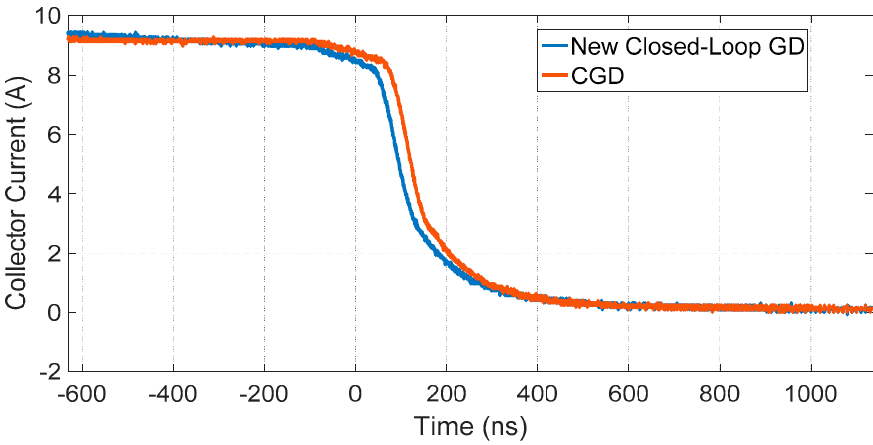
Figure 9. The resultant i C from the closed-loop GD and CGD at turn-off condition. Table 3. The performance index.